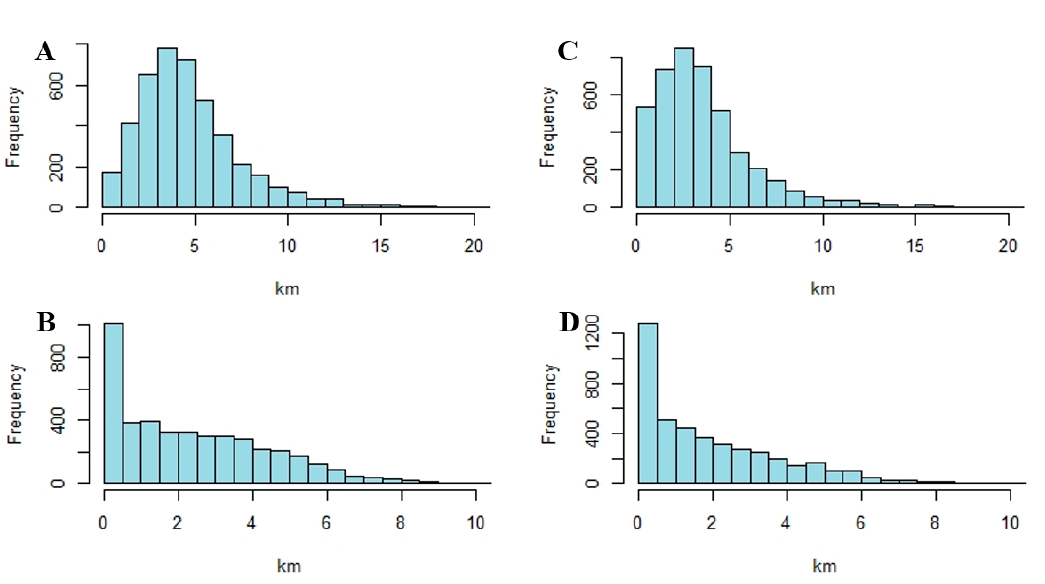
Figure 6. ( A ) Average distance to each tweet from COM—all tweets; ( B ) Average distance to each park tweet from park COM; ( C ) Median distance to each tweet from COM—all tweets; ( D ) Median distance to each park tweet from park COM.